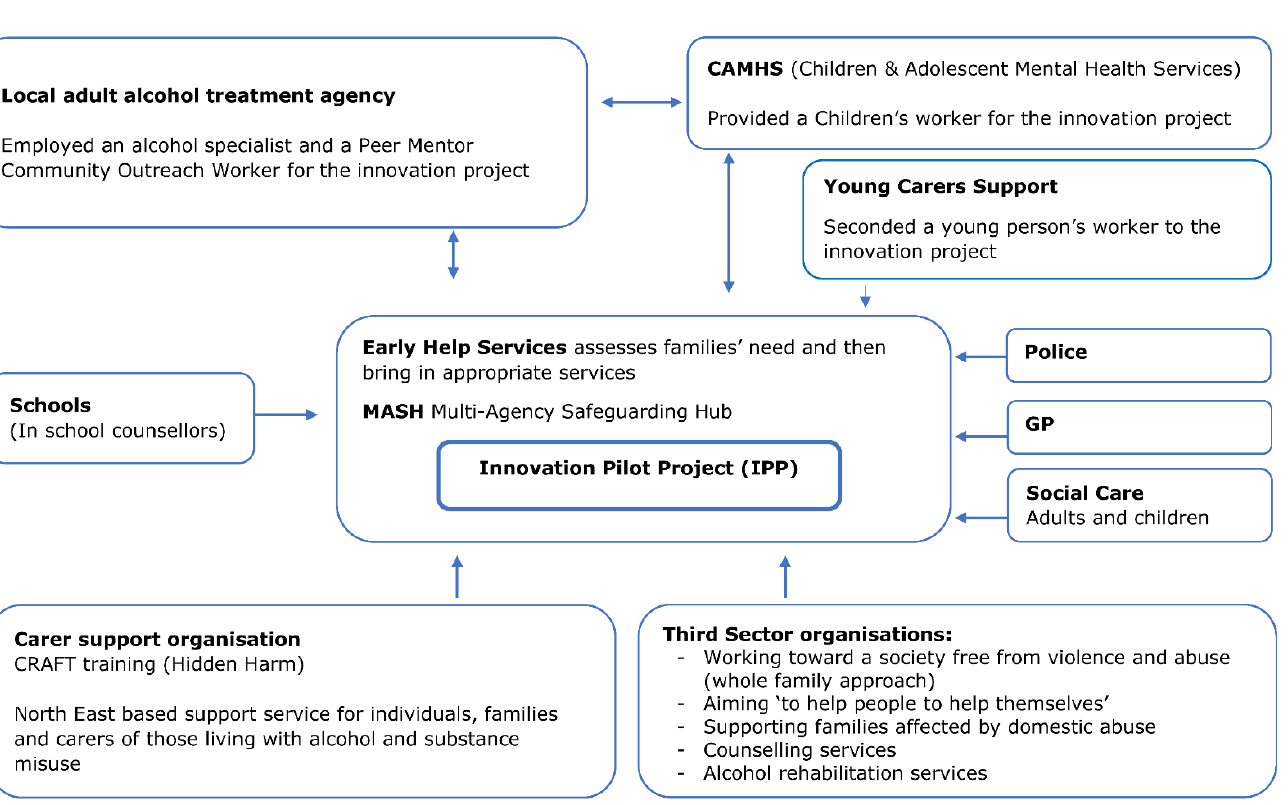
Figure 1. Innovation pilot project multi-agency collaboration.